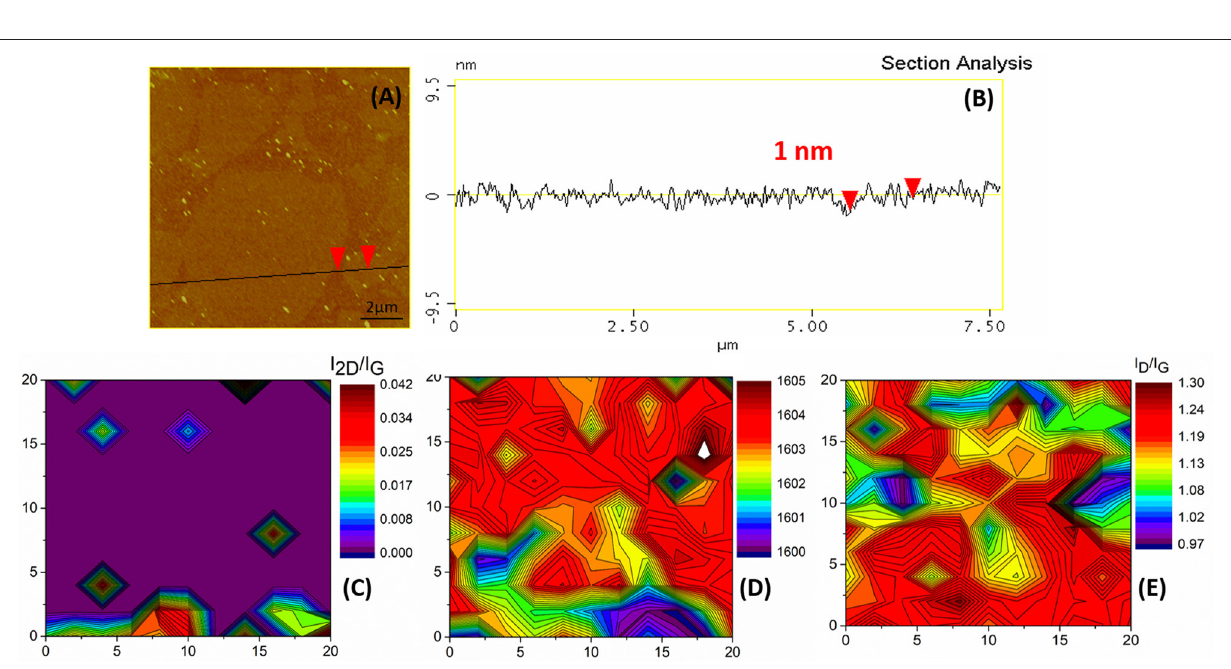
acquired via Raman spectroscopy ( Figure 4 ). The wide D peak still existed, although with slightly decreased FWHM by 7 cm − 1 . The D” and A bands attributed to amorphous carbon were not